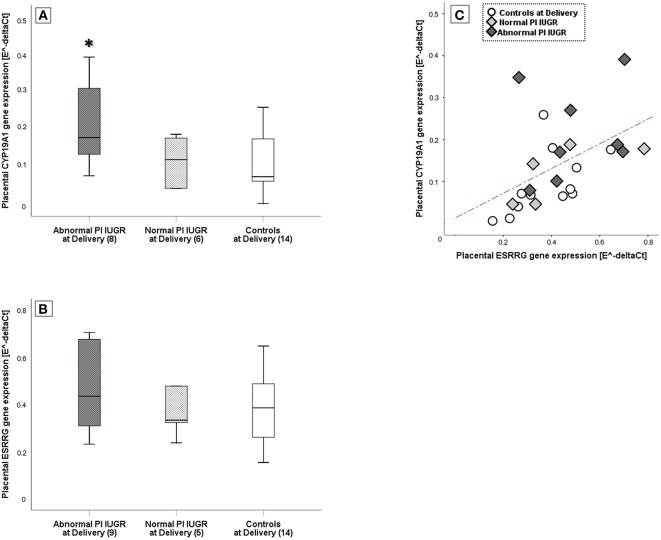
ESRRG and CYP19A1 expression in placental tissue. (A)
CYP19A1 and (B)
ESRRG mRNA levels in IUGR with Abnormal or Normal umbilical artery Pulsatility Index- PI and Controls at Delivery; relative mRNA levels derived according to geNorm method and data shown as Box Plots graphs. Statistical analysis by One-way between-groups ANOVA: *p ≤ 0.05 vs. Controls at Delivery. (C) Significant positive correlation between ESRRG and CYP19A1 expression in Controls at Delivery (○), Normal PI (), or Abnormal PI () IUGR. Statistical analysis by Pearson product-moment correlation: r = 0.50/p ≤ 0.01.